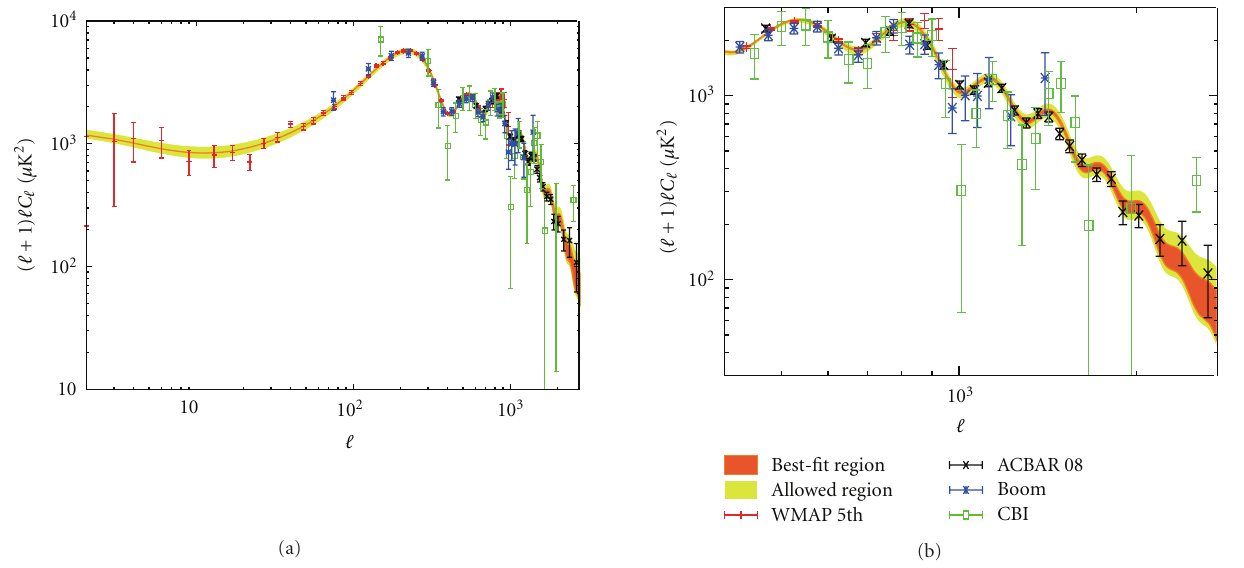
Figure 12: Comparison of the best-fit computed total power spectrum with the observed CMB spectra. Plots show various ranges for (a) TT (2 < (cid:11) < 2750) and (b) TT (400 < (cid:11) < 2750) modes. Orange regions are from the best-fit parameter set, and allowed regions are from constrained parameter set as Table 1. Red, black, blue, green, orange, and purple dots with error bars show WMAP 5 years, ACBAR 08, Boomerang, and CBI data, respectively. Since the SZ e ff ect depends upon frequencies of the CMB for the TT mode, we plot the best fit and allowed regions in (a) and (b) surrounded by the curves with the SZ e ff ect at the K (22.8GHz) band (upper curves) and without the SZ e ff ect (lower curves).